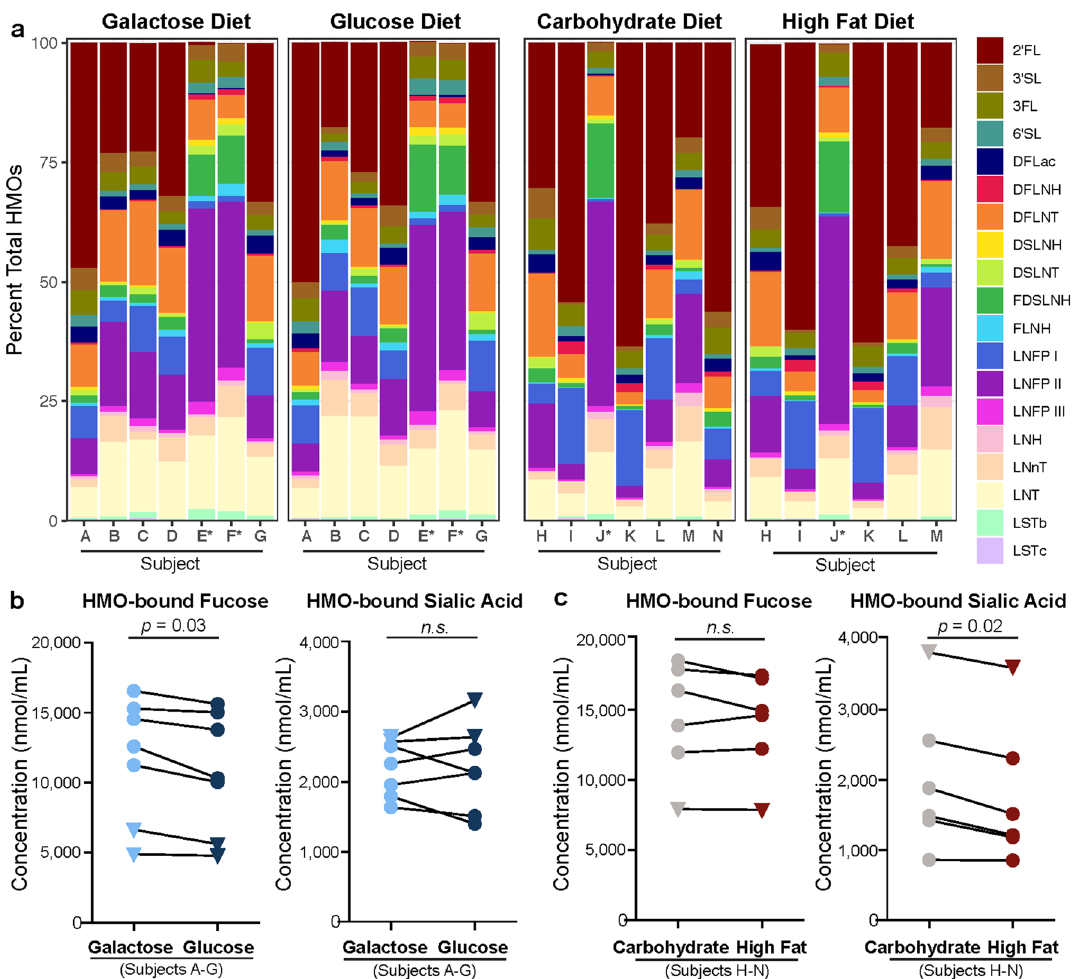
Figure 2. Maternal diet alters the HMO profile of human milk. ( a) Relative abundance of individual HMO in each cohort based on molar concentration (green: fucosylated HMO, purple: sialylated HMO; A–N: subject identifiers; asterisks: non-secretors). ( b) HMO-bound fucose is significantly decreased after glucose diet relative to galactose diet (paired t-test, p = 0.03), with no discernable change in HMO-bound sialic acid. ( c) High fat diet significantly decreases HMO-bound sialic acid (paired t-test, p = 0.02), with no discernable change in HMO- bound fucose. Circles: secretors; triangles: non-secretors. 2 ′ FL 2 ′ -fucosyllactose, 3FL 3-fucosyllactose, DFLac difucosyllactose, LNFP lacto- N -fucopentaose, DFLNT difucosyllacto- N -tetraose, FLNH fucosyllacto- N -hexaose, DFLNH difucosyllacto- N -hexaose, 3 ′ SL 3 ′ -sialyllactose, 6 ′ SL 6 ′ -sialyllactose, LST sialyllacto- N -tetraose, DSLNT disialyllacto- N -tetraose, DSLNH disialyllacto- N -hexaose, FDSLNH fucosyl-disialyllacto- N -hexaose, LNnT lacto- N -neotetraose, LNT lacto- N -tetraose, LNH lacto- N -hexaose. In the high fat dietary intervention, 1 subject’s sample (“subject N”) had an insufficient volume (< 20 μl) to rerun a when QC for a high quality chromatogram failed 29 . As a result, subject N was dropped from the paired analysis shown in panel ( c